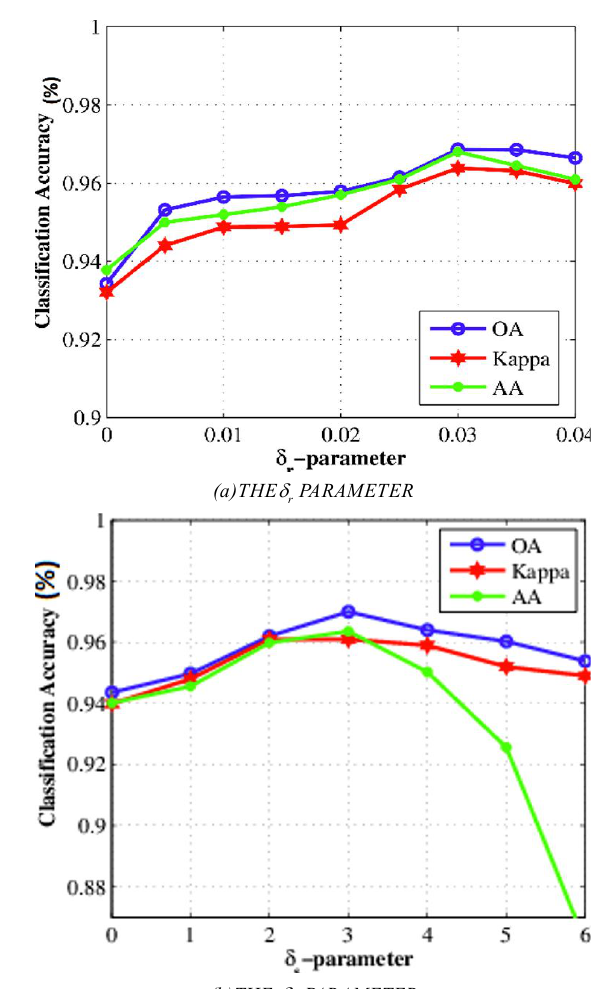
FIG. 5. IMPACT OF THE BILATERAL FILTERING